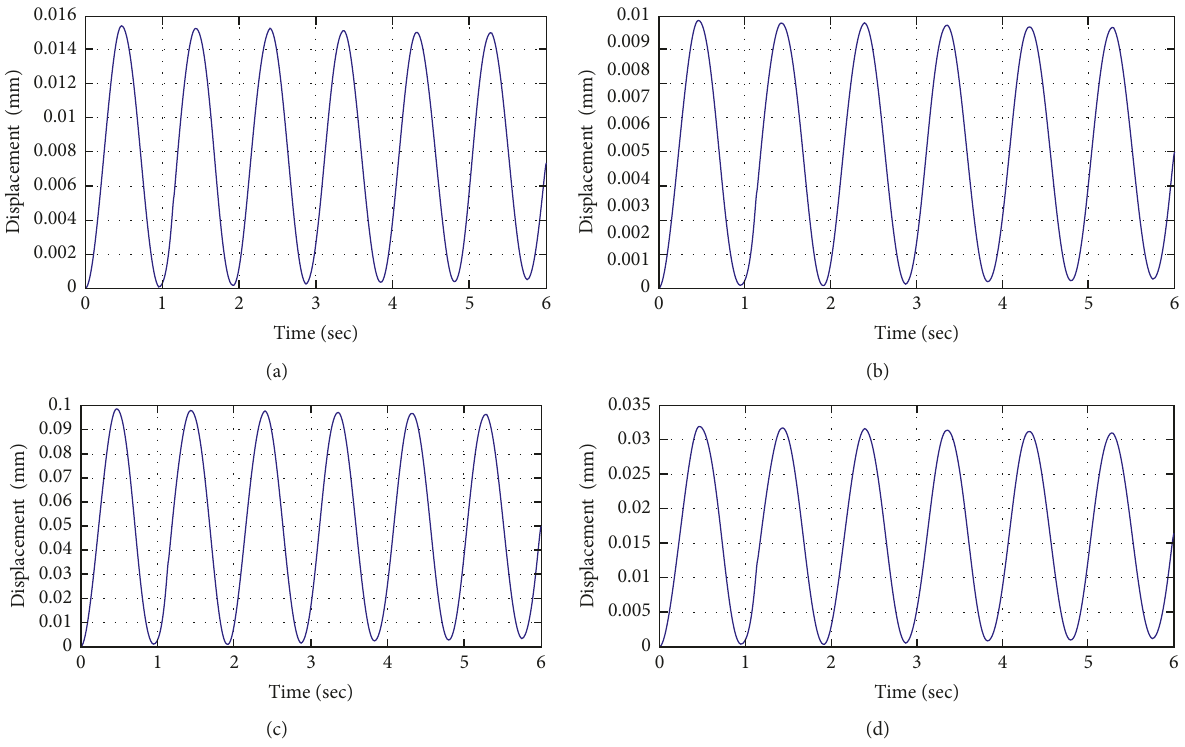
Figure 19: Displacement for flat face plug with flow velocity 1m/s and different valve opening. (a) 10% valve opening; (b) 20% valve opening; (c) 30% valve opening; (d) 40% valve